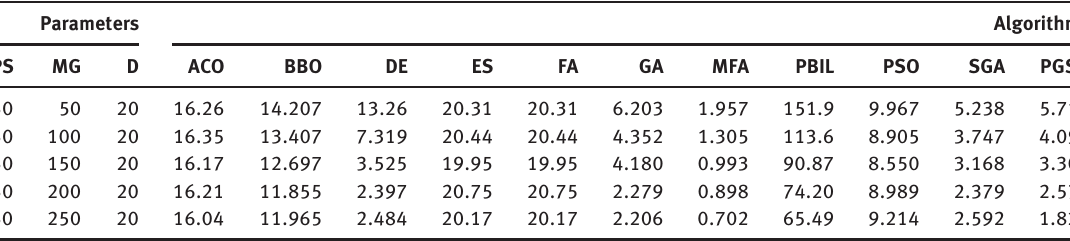
Table 7. Mean Optimization Results on Different Evolutionary Generations. Para meters